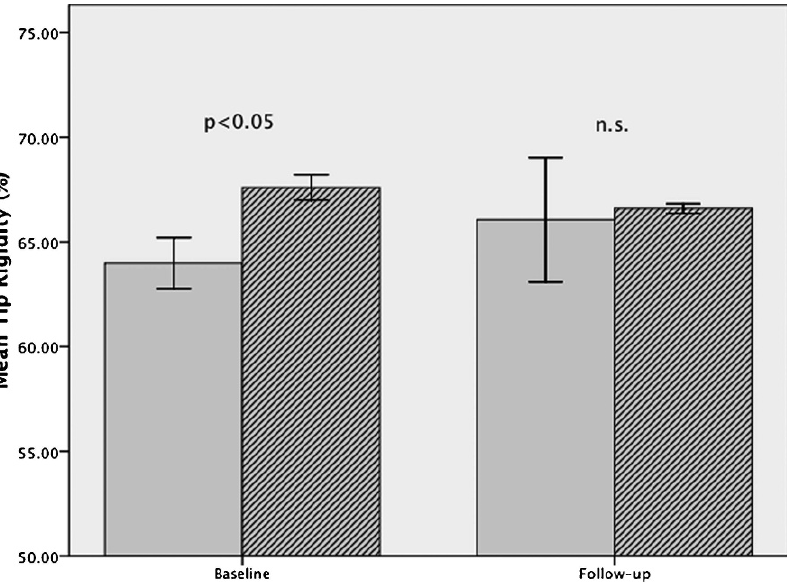
Figure 2 - Penis mean tip rigidity at baseline and at 3-months’ follow-up in lying (left bars) and standing (right bars) position. Whiskers represent two standard deviations. n.s. =